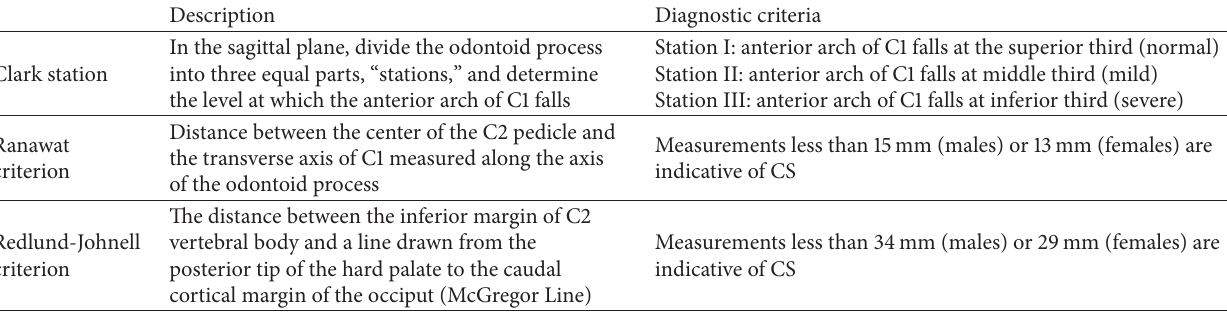
Table 3: Indices of cranial settling [17].